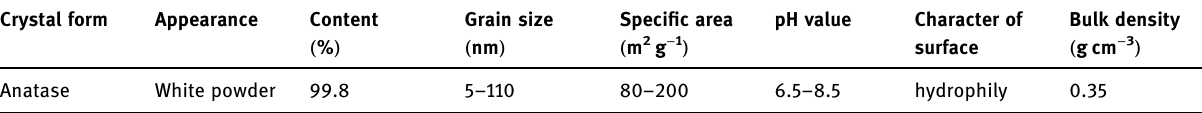
Table 2: Basic properties of anatase Crystal form